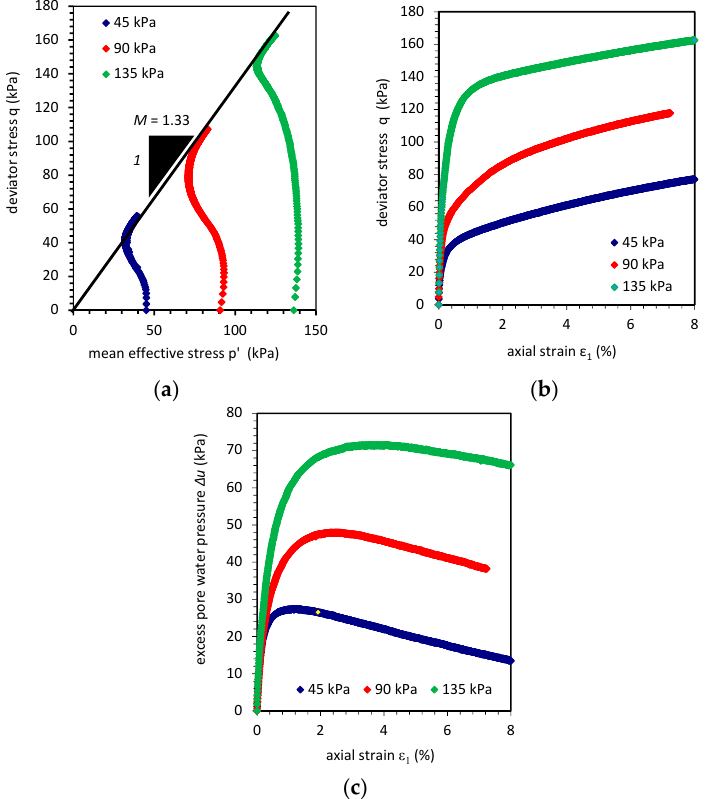
Figure 1. Results of the static triaxial test for sandy silty clay under confining pressure of 45 kPa, 90 kPa, and 135 kPa and under the isotropic consolidation: ( a ) The deviator stress–mean effective stress relationship, ( b ) deviator stress–vertical strain relationship, and ( c ) excess pore water pressure versus vertical strain characteristic.